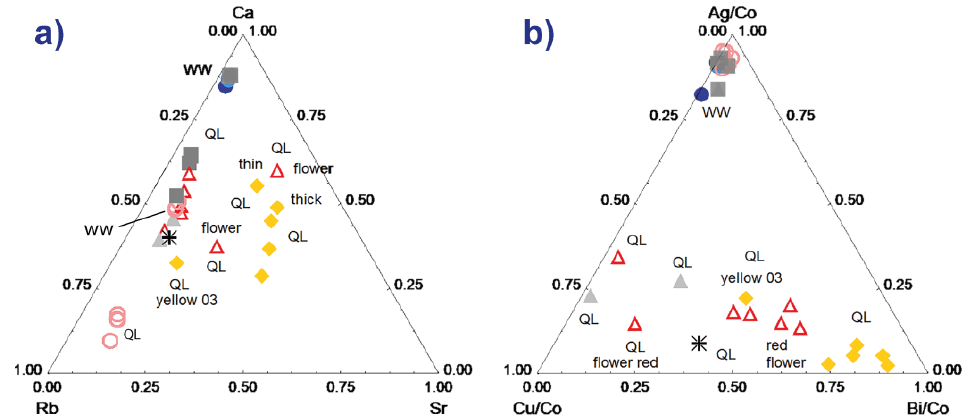
Figure 6. Comparison of the characteristic signal (peak areas) of the elements Ca-Rb-Sr ( a ) and Ag-Cu-Bi normalized with respect to the signal of cobalt ( b ) for the different colored areas (see symbols in the previous figure) of the two analyzed samples.